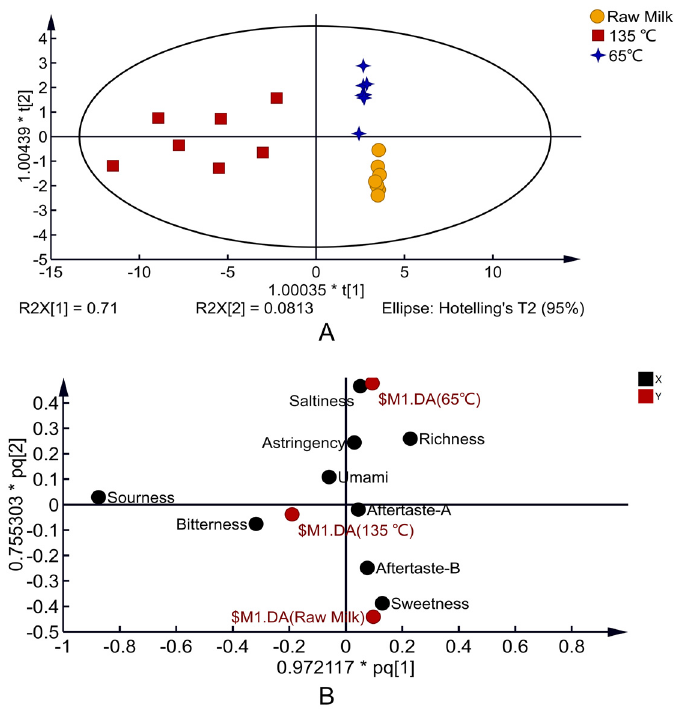
Figure 3. OPLS-DA 2D score map of milk E-tongue with different temperatures ( A ) and load diagram ( B ).